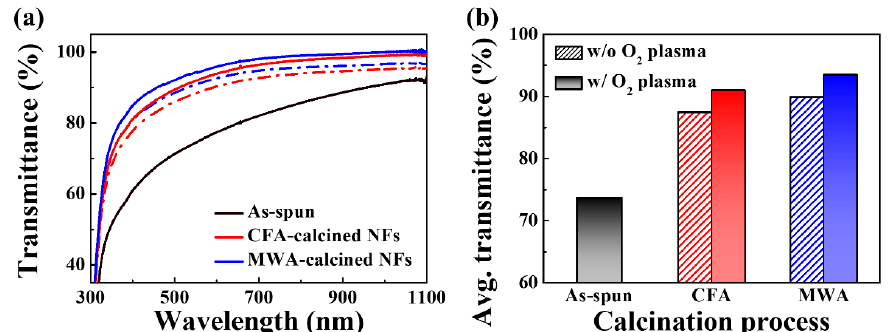
Figure 4. ( a ) Transmittance spectra and ( b ) average transmittances in visible light of electrospun IGZO NFs formed on glass substrates before and after calcination and oxygen plasma treatment.